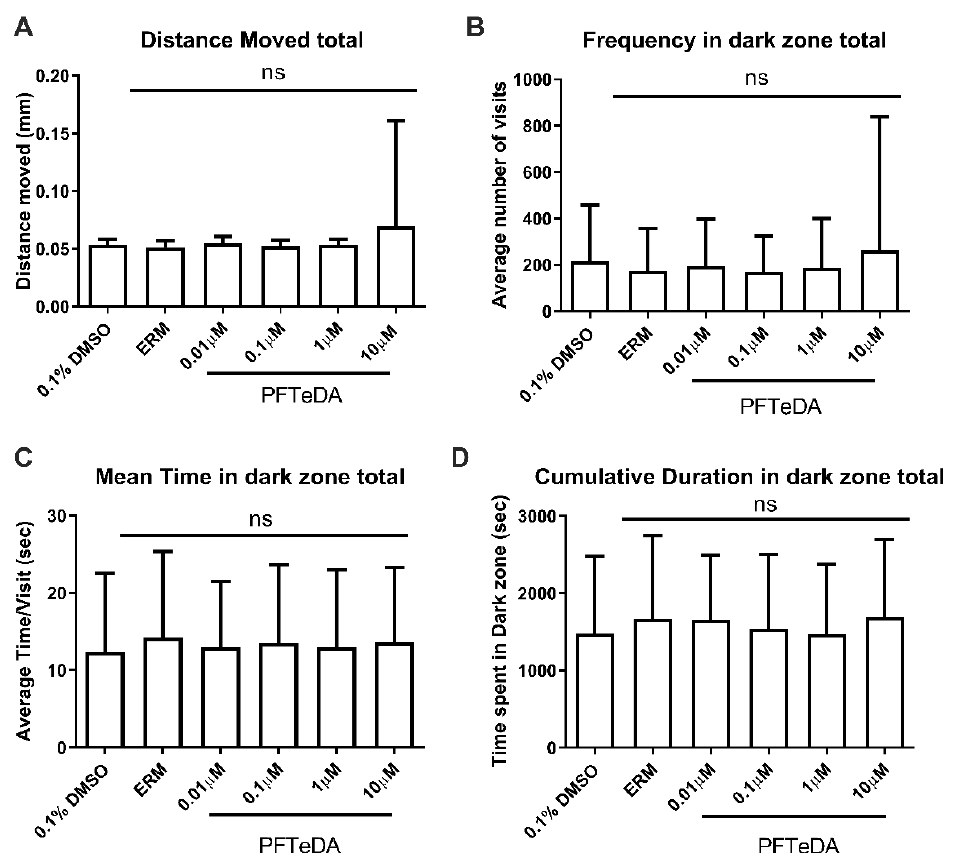
Figure 7. The light–dark preference test for anxiolytic behavior. ( A ) Total distance moved; ( B ) Fre- quency in dark zone; ( C ) Mean time in dark zone; ( D ) Cumulative duration in dark zone. Mean values are depicted by the individual columns that correspond to a treatment group (mean ± S.D.) (one-way ANOVA with a Dunnett’s multiple comparisons test, n = 31–46 fish/treatment, combined 3 trials). The ns = not significant